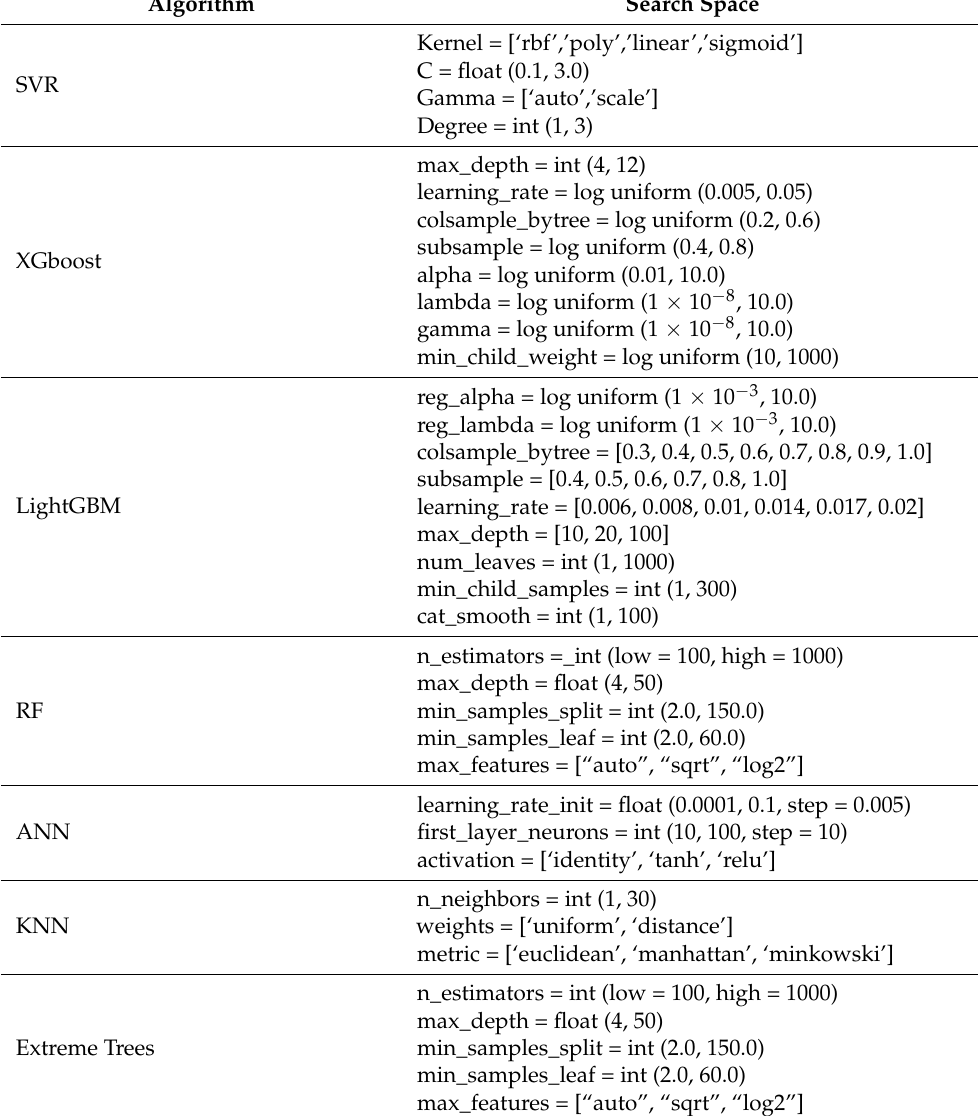
Table 3. Search space configuration for hyperparameter optimization using